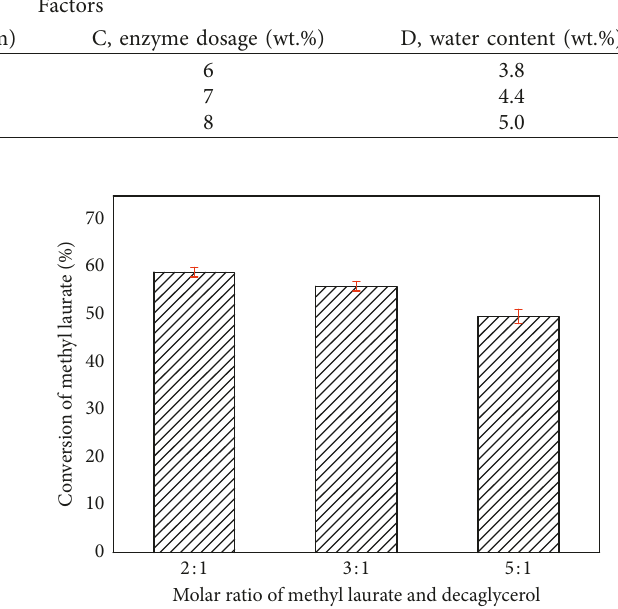
Figure 2: Effect of molar ratio on lipase-catalyzed trans- esterification of decylglycerol with methyl laurate.